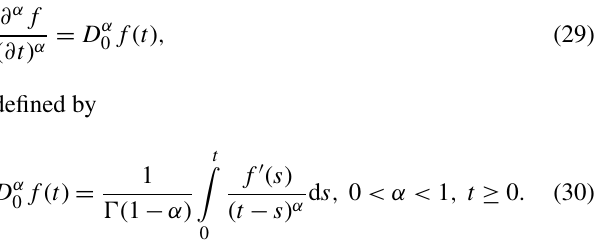
Figure 3. Nondimensional groundwater hydraulic heads through time at x = L/ 2, when fractional space and time derivatives are β x = α = 0.8, 0.9, 1.0, where L is the length of the aquifer and β x and α are the fractional orders in space and time,